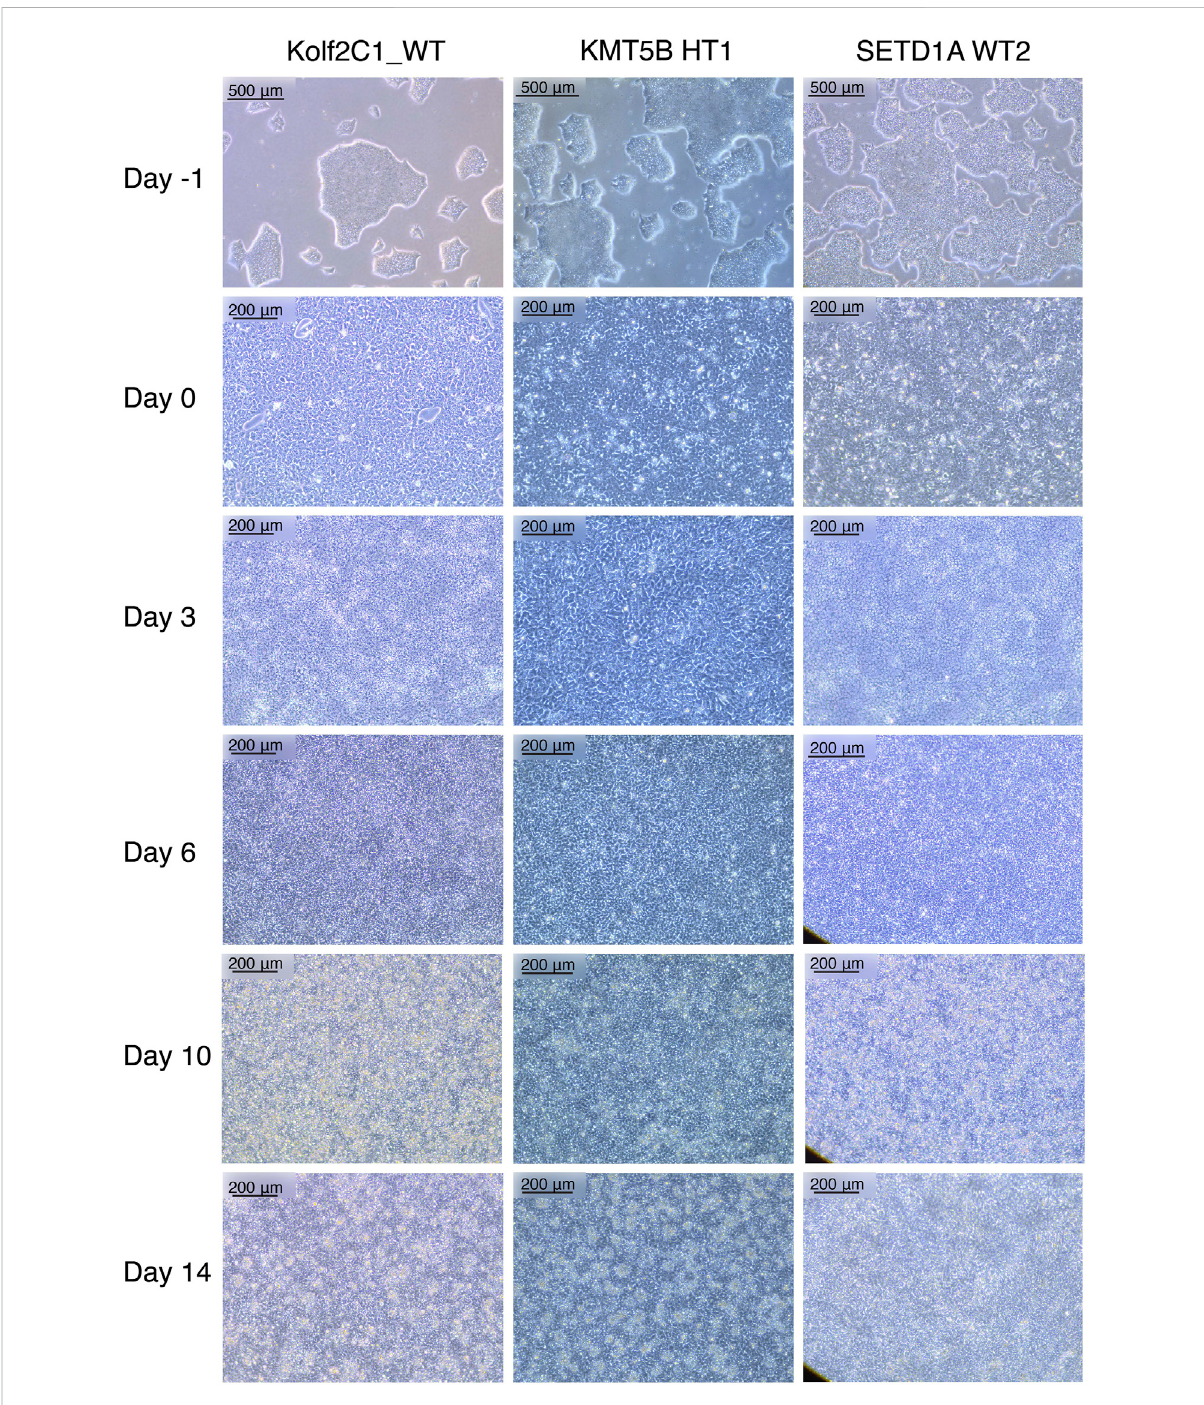
FIGURE 2 Representative cell lines at each stage of the 14 days neural differentiation protocol. Displayed are images of Kolf2C1_WT, a heterozygous KMT5B knockout (KMT5B HT1) and a wild-type line from the SETD1A gene set (SETD1A WT2). Note the differences in morphology between each of the cell lines, but all of these examples constitute acceptable morphology at each stage. For example, SETD1A WT2 has clear neural rosettes on Day 14, whereas the others do not. Scale bars: Day -1, 500 μ m (5x). All other images: 200 μ m